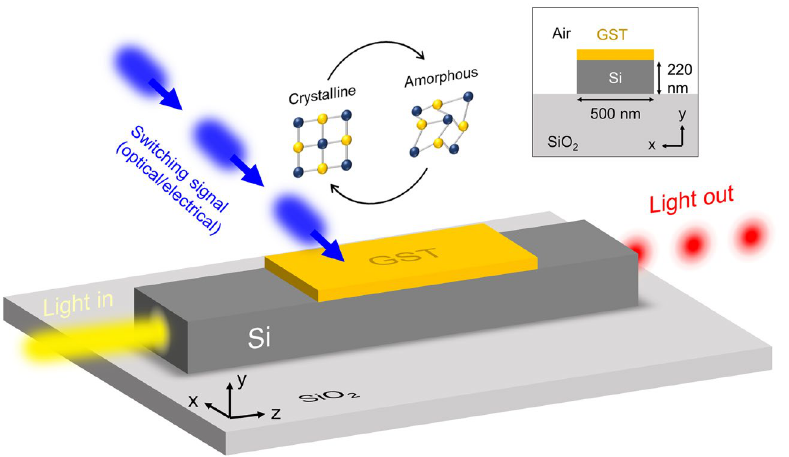
Figure 1. Illustration of a GST-loaded silicon waveguide and its working principle for optical switching. The GST switches between crystalline and amorphous states upon an optical or electrical switching signal. Between both states, the refractive index of the GST suffers a dramatic change in both real and imaginary parts, resulting in an amplitude and phase modulation of the output light. Inset shows the cross-section and the dimensions of the GST/Si